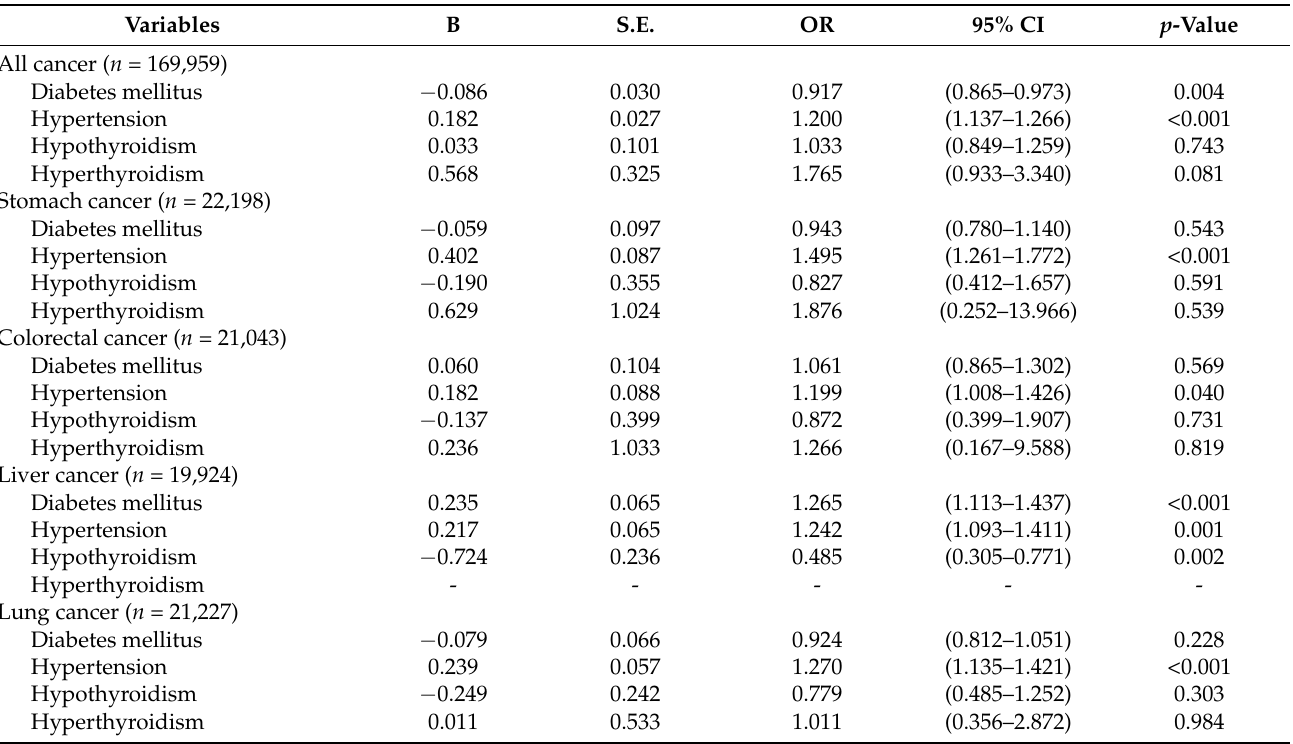
Table 4. Logistic regression analysis of mortality factors according to